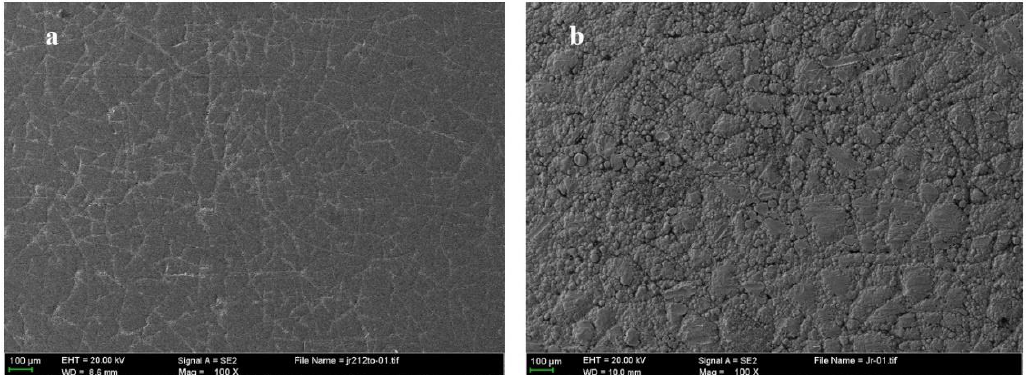
Figure 2. Surface topography of piston rings with Cr ( a ) and CuSn-Cr coatings ( b ).